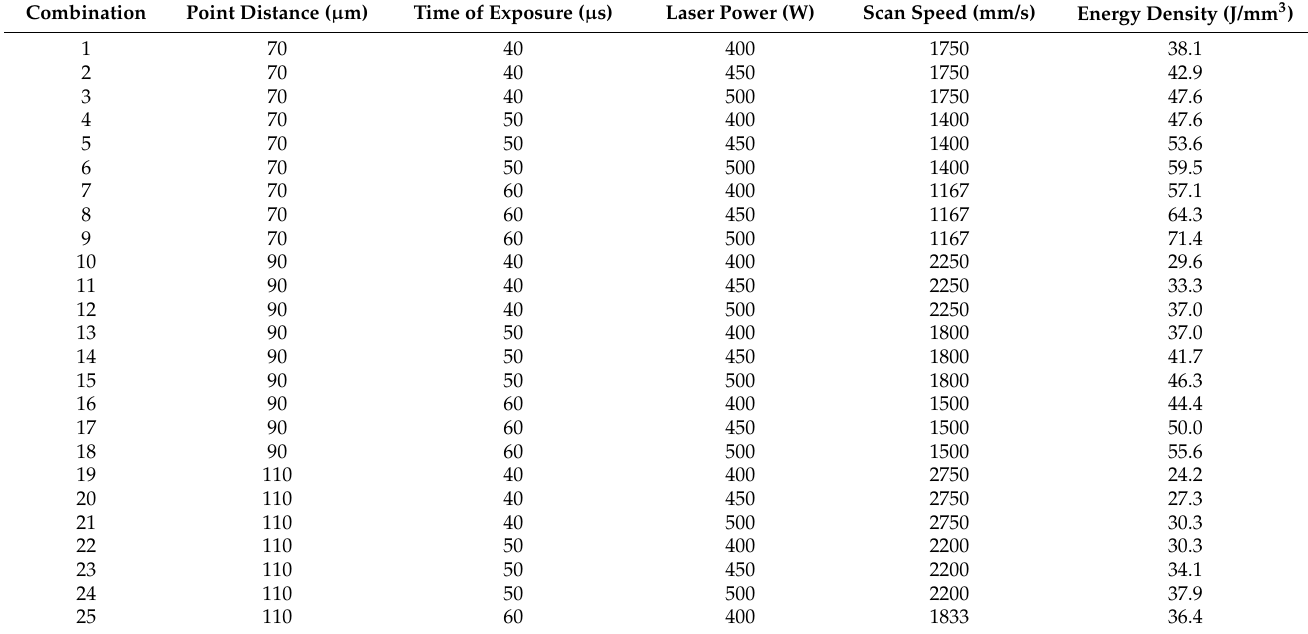
Table 1. Combinations of process